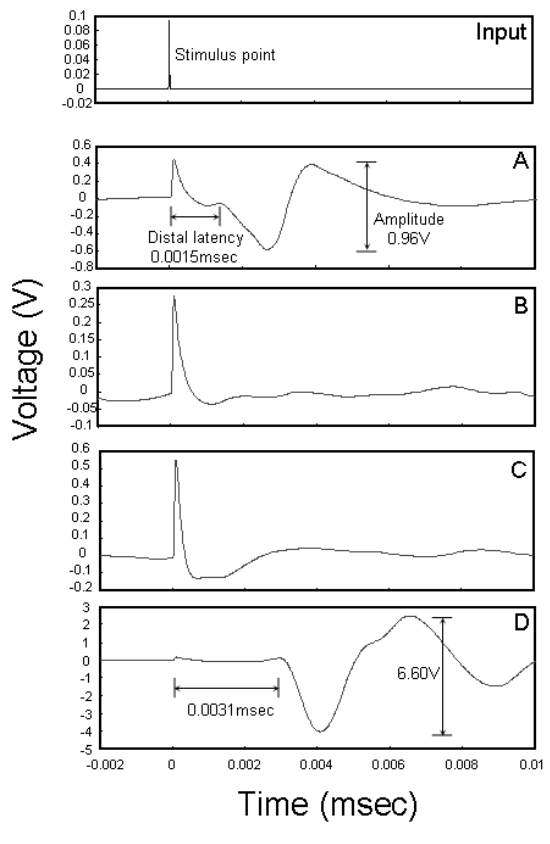
Figure 6. Electrophysiological analysis of sciatic nerves six months after implantation: ( A ) Healthy nerve; ( B ) Nerve with implanted silicone tube (used as a control); ( C ) Nerve with implanted PLLA conduit; ( D ) Nerve with implanted PLLA/ODLA-AG73